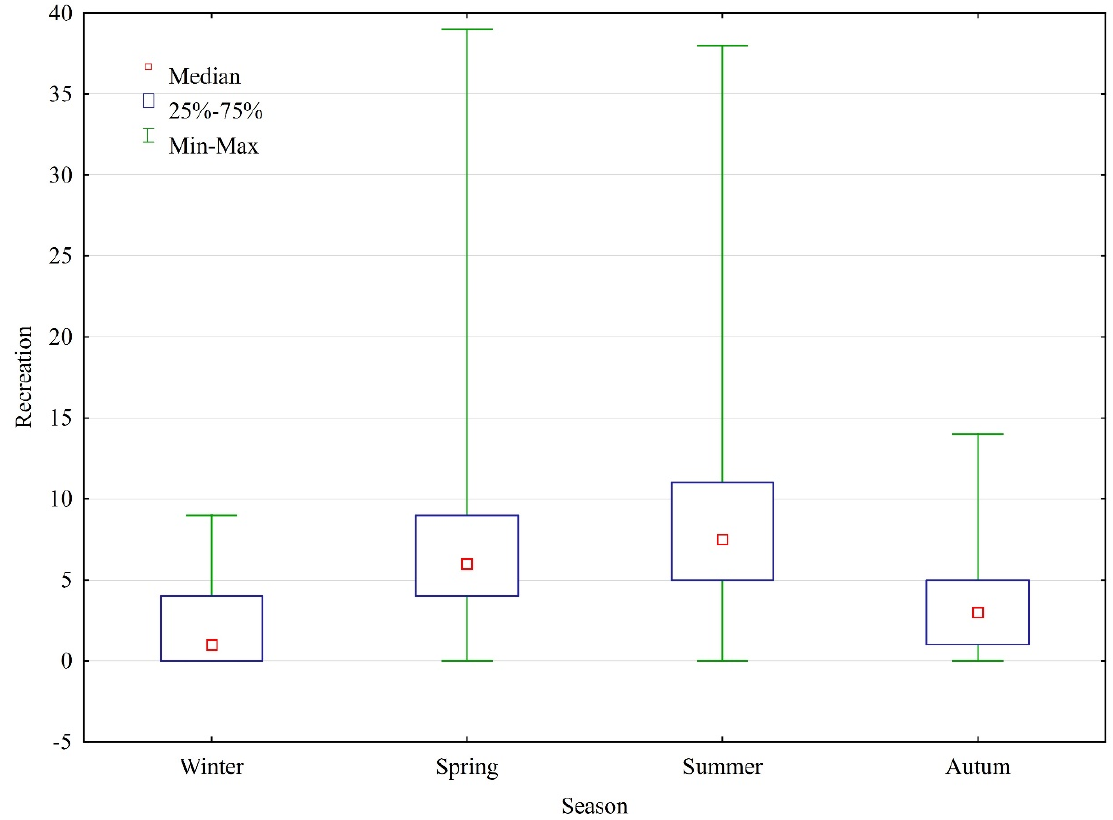
Figure 4. Kruskal–Wallis ANOVA comparison of median values of the daily number of recreational activities in individual seasons, p = 0.000. Table 4. Multiple comparisons of mean ranks of recreation activities for all pairs of groups (Season). P values are two-sided significance levels with a Bonferroni adjustment.